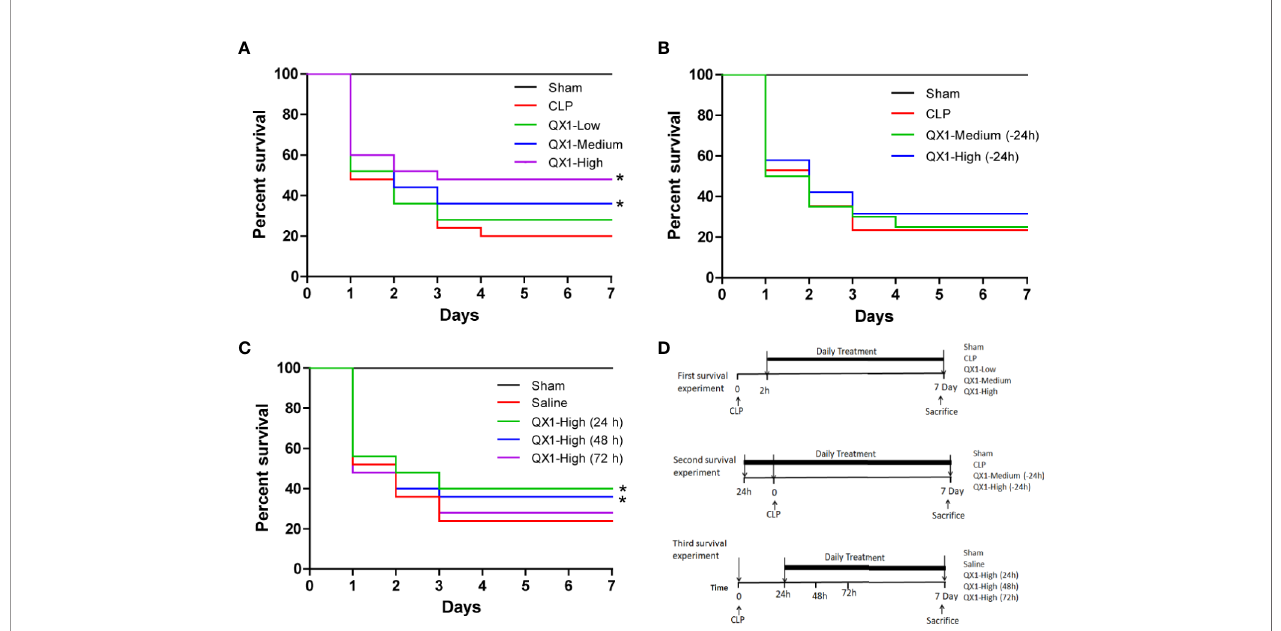
FIGURE 2 | QX1 formula improves survival in septic mice. Kaplan – Meier curves for 7 days demonstrate the survival rate. (A) Percent survival of mice orally administrated QX1 formula 2 h after surgery. The dosages indicated as low, medium, and high dose were 0.5 g, 1 g, and 2 g/kg·bw, respectively. (n = 25 per group). (B) Percent survival of mice orally administrated QX1 formula 24 h before sepsis onset. The dosages used were medium or high dose with 1 or 2